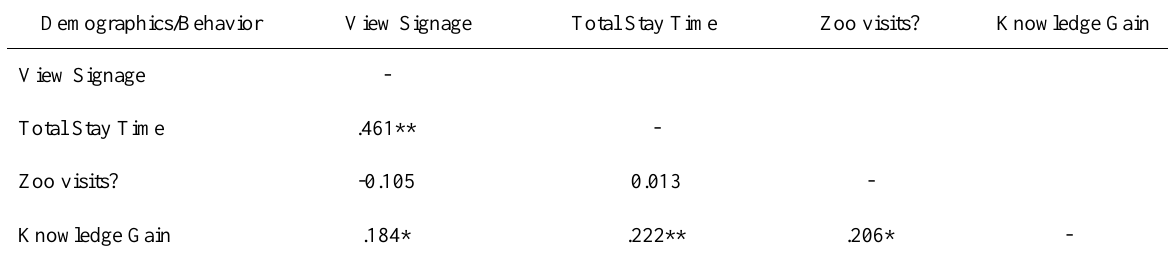
Correlations Between Various Aspects of Behavior, Knowledge, and Demographic Characteristics Demographics/Behavior View Signage Total Stay Time Zoo visits? Knowledge Gain View Signage - Total Stay Time .461** - Zoo visits? -0.105 0.013 - Knowledge Gain .184* .222** .206* - Note : * p < .05, ** p <